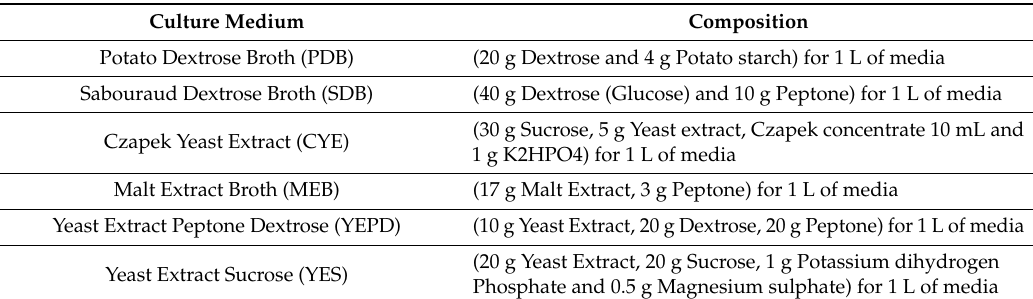
Table 2. The culture media and their